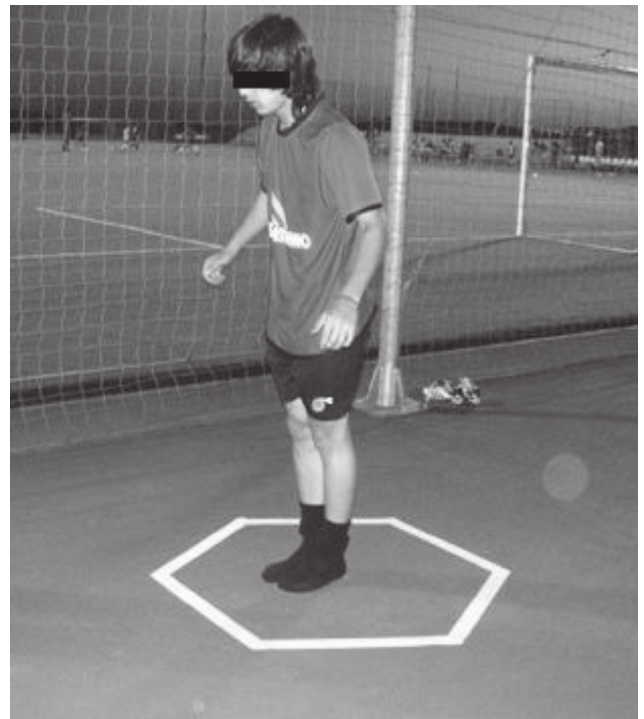
Figura 3 - Hexagon